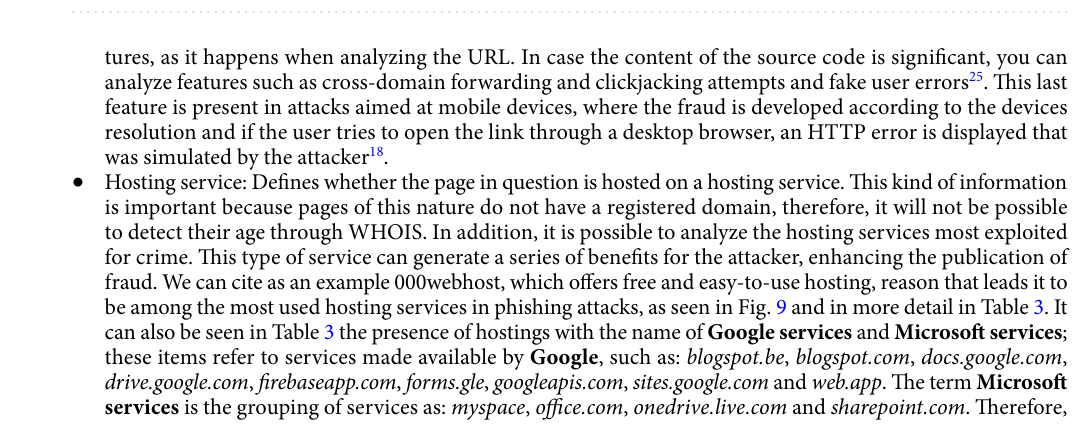
Figure 8. Phishing with and without content-page over 2016 to